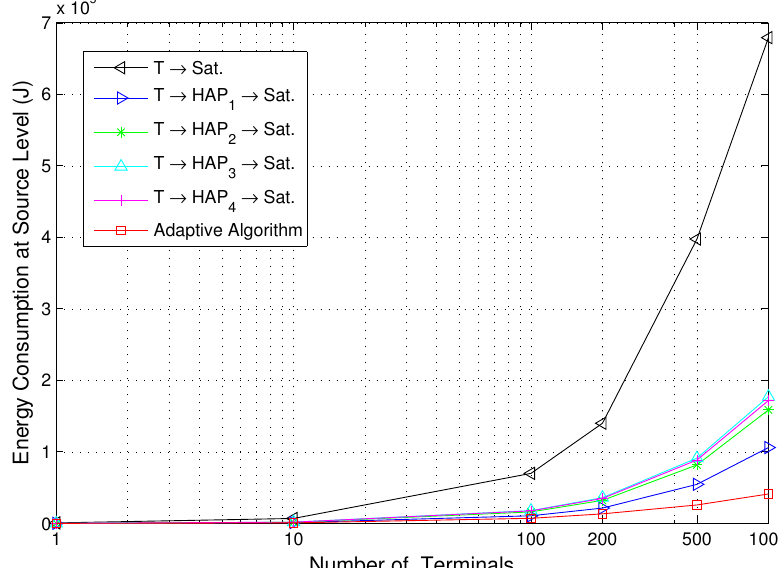
Figure 5. Energy consumption for the direct path, relay paths and adaptive path selection versus the number of terminals at the source